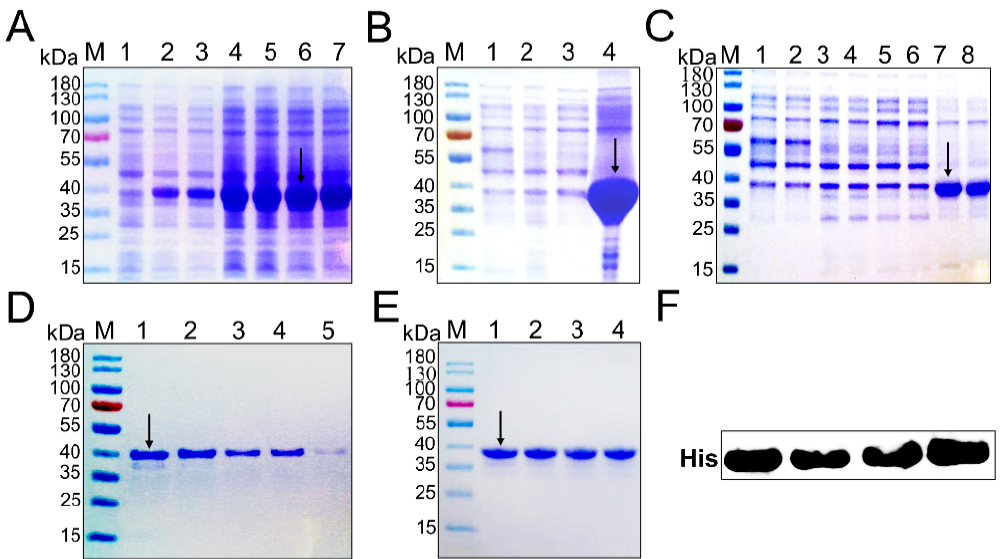
Figure 2. Expression and purification of RIPK3 protein. ( A ) Induction of recombinant protein expression at 37 ◦ C; lane 1: total protein of non-induced pET-32a-RIPK3 protein; lane 2–7: total protein of pET-32a-RIPK3 protein was induced for 4 h, 6 h, and 8 h, respectively. ( B ) Identification of the expression form of recombinant protein induced at 37 ◦ C after ultrasound; lane 1: total protein supernatant of non-induced pET-32a-RIPK3 protein; lane 2: total protein sediments of non-induced pET-32a-RIPK3 protein; lane 3: total protein supernatant of induced pET-32a-RIPK3 protein; lane 4: total protein sediments of induced pET-32a-RIPK3 protein. ( C ) Identification of the expression form of recombinant protein induced at 20 ◦ C after ultrasound; lane 1–2: total protein supernatant of non-induced pET-32a-RIPK3 protein; lane 3–4: total protein sediments of non-induced pET-32a-RIPK3 protein; lane 5–6: total protein supernatant of induced pET-32a-RIPK3 protein; lane 7–8: total protein sediments of induced pET-32a-RIPK3 protein. ( D ) Determination of optimum imidazole concentration; lane 1–5: the target protein was eluted with imidazole eluting buffer (100, 200, 300, 400, 500 mM) at gradient concentration. ( E ) lane 1–4: the target protein was concentrated after dialysis; M: the standard protein Marker (15–180 kDa). ( F ) His tag of purified target protein was verified by Western blot. The short black arrows indicate RIPK3 protein bands.